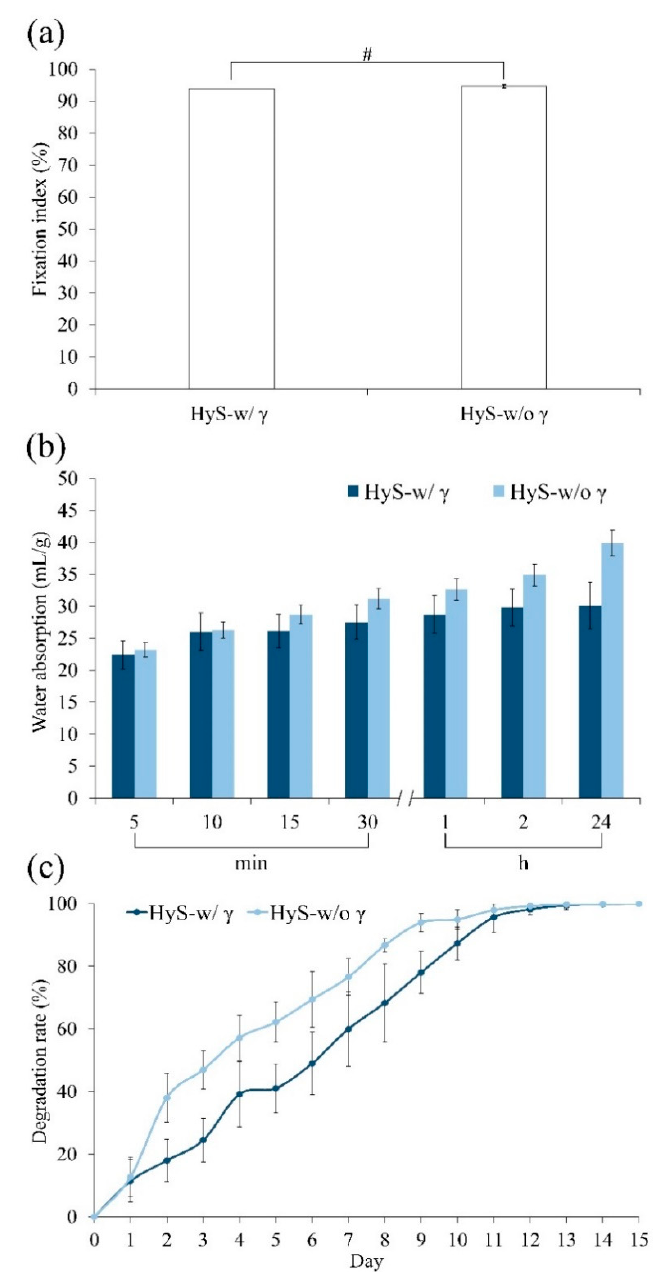
Figure 4. Physiochemical analysis of hydrogel macrospheres before (HyS-w/o γ ) and after (HyS- w/ γ ) sterilization corresponds to amine fixation index ( n = 6, #: p > 0.05) ( a ), water absorption ratio ( n = 10) ( b ), and degradation rate ( n = 10) ( c ).